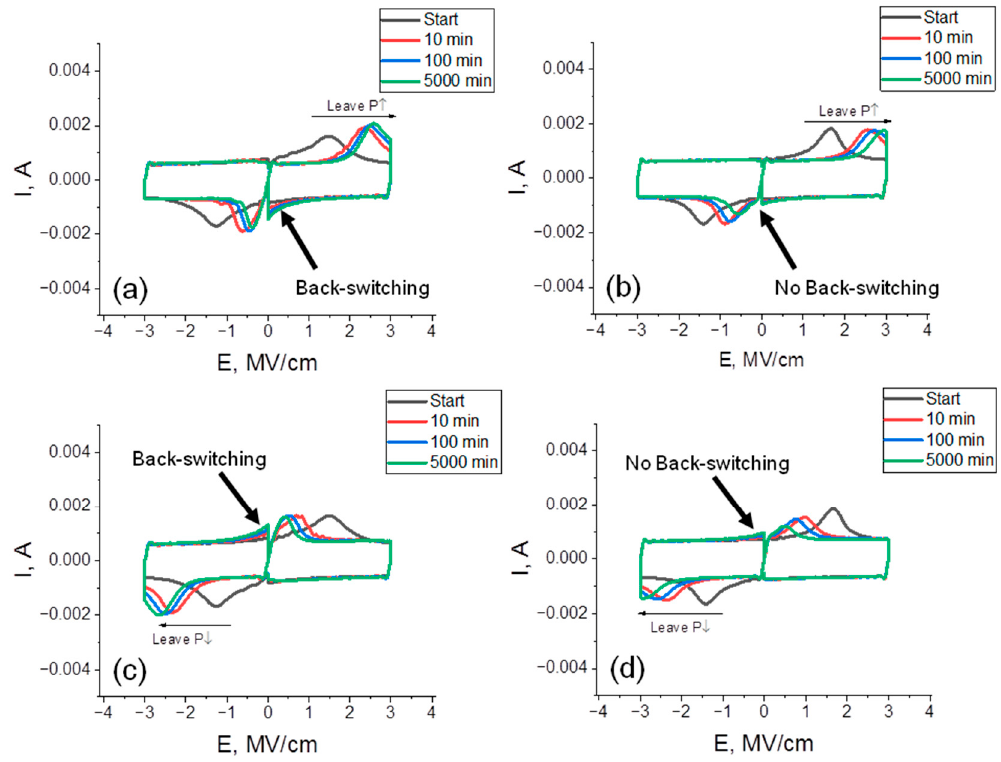
Figure 6. Dynamic I sw -E curves of the devices with TiN TE ( a , c ) and Ru TE ( b , d ) measured at the pristine state and after baking at 85 °C for 10, 100 and 5000 min.